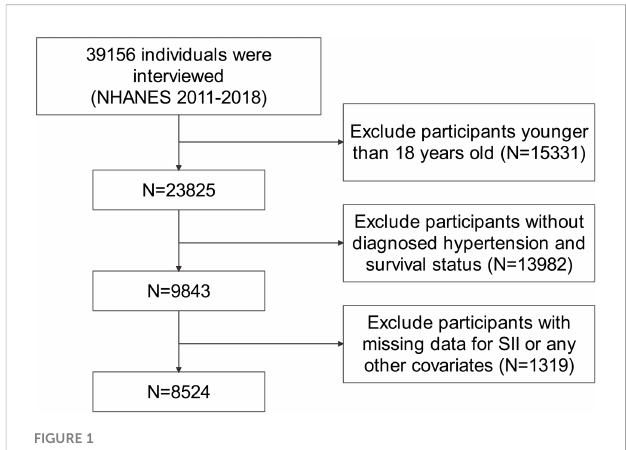
FIGURE 1 Flow diagram of the selection of eligible